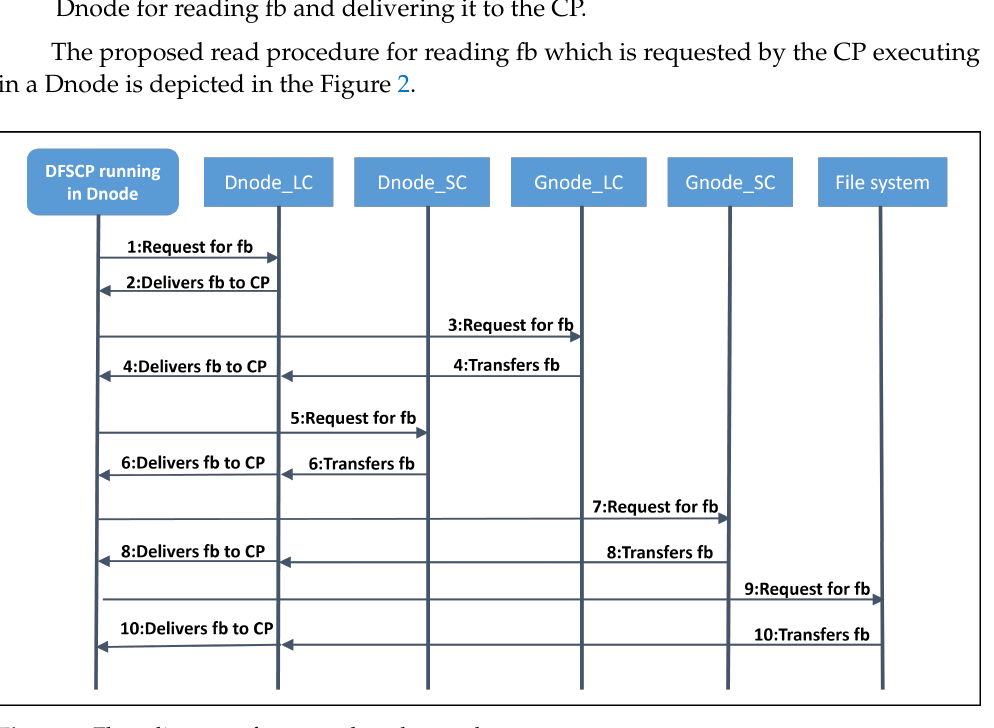
Figure 2. Flow diagram of proposed read